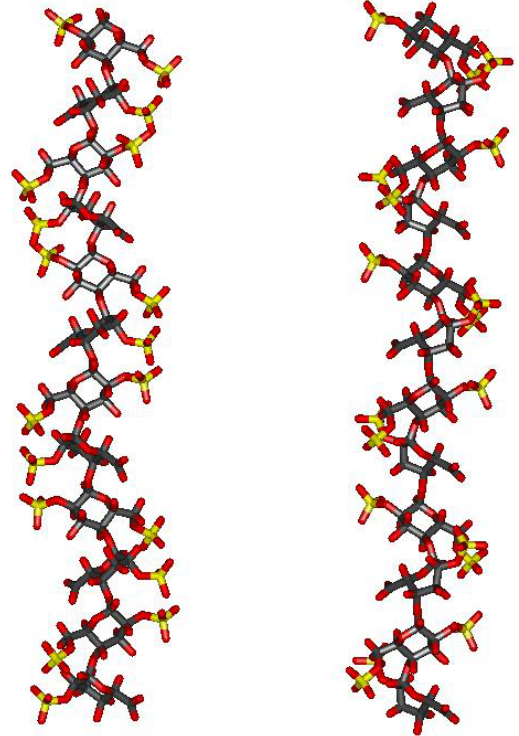
Fig. 5 – The solution structure of heparin, as determined by NMR spectroscopy. The two models have iduronate residues in the 1 C 4 and 2 S 0 conformationsrespectively. Sulfatesubstituents are arranged along the polysaccharide chain in groups of three, alternating on opposite sides of the molecule. Co-ordinates are from the PDB file 1HPN. The stick representation is colored grey